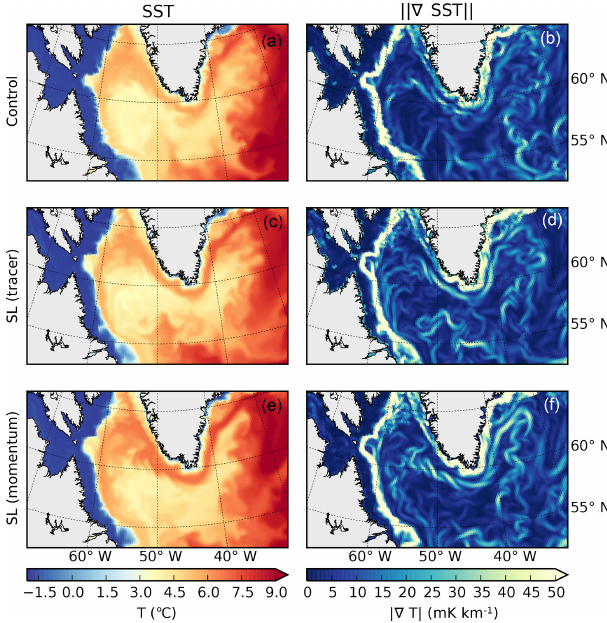
Figure 10. (a, c, e) Sea surface temperature and (b, d, f) the mag- nitude of its gradient for the (a, b) control, (c, d) semi-Lagrangian tracer, and (e, f) semi-Lagrangian momentum and tracer test cases of Sect. 5.2, for 31 December 2005 in the Labrador Sea. Although the large-scale flows are similar, the runs with semi-Lagrangian ad- vection of tracers have noticeably more fine-scale